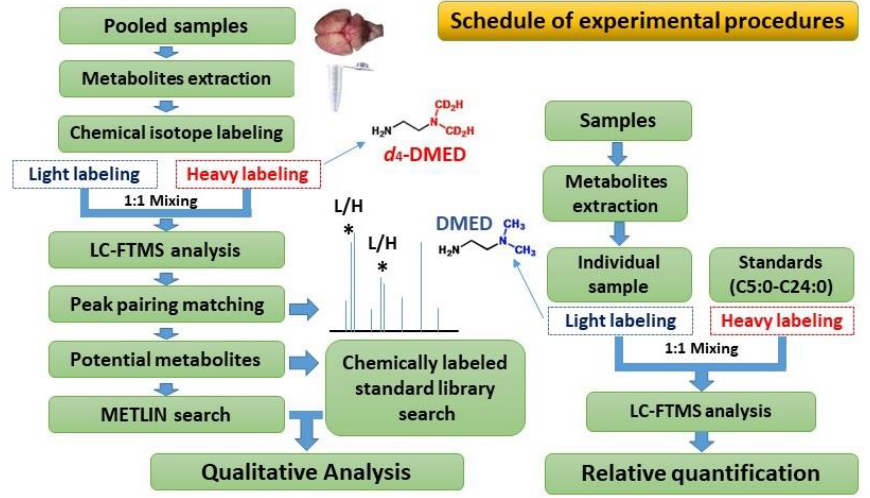
Figure 7. Schedule diagram of the procedure for determination of fatty acids in rat brain by the chemical isotope labeling liquid chromatography–mass spectrometry (CIL-LC-MS) method;